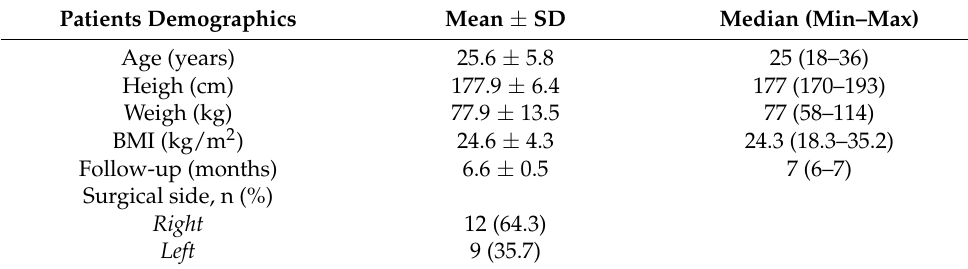
Table 1. Patient demographic characteristics (total